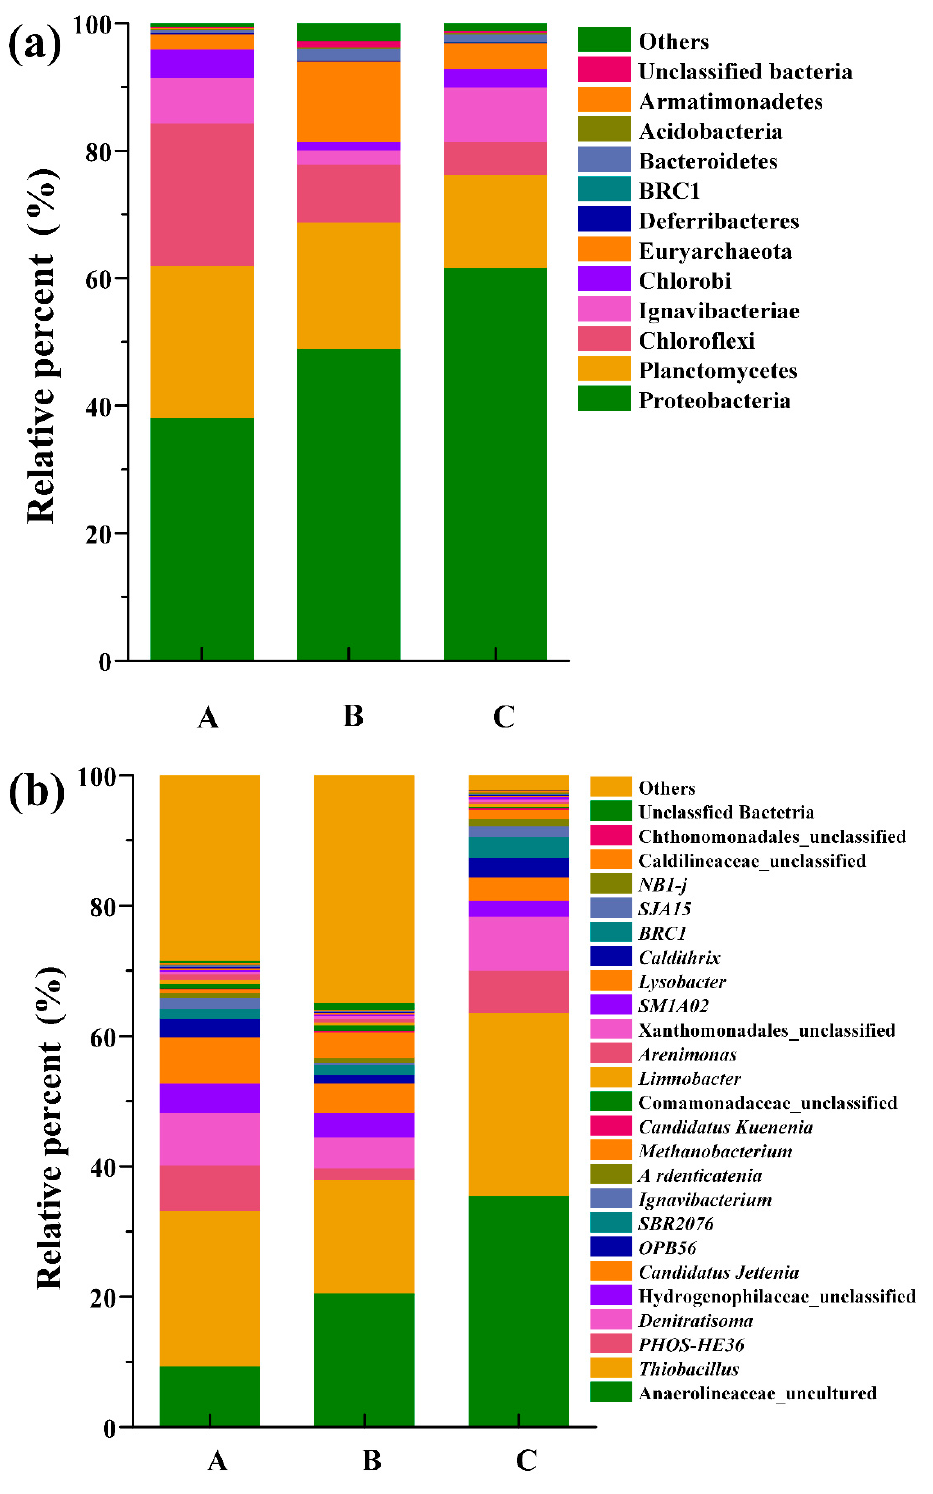
Figure 6. Variations in microbial community structure in the A / SAD / HD reactor at the phylum ( a ) and genus ( b ) levels. (A: the end of phase I (stage I); B: the end of stage I; C: the end of stage II.)